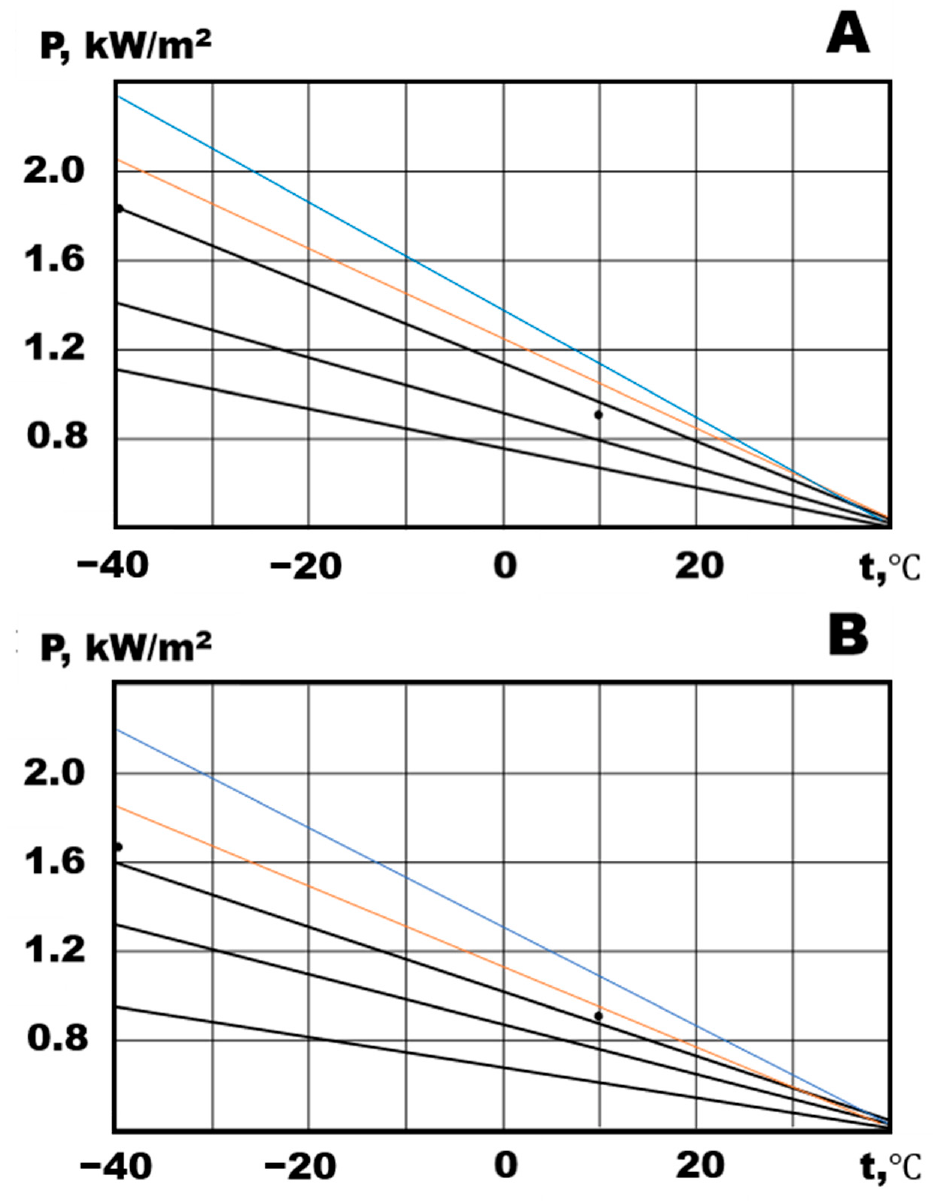
Figure 6. Specific power of heat: ( A ) NCO 1 and ( B ) NCO 2.